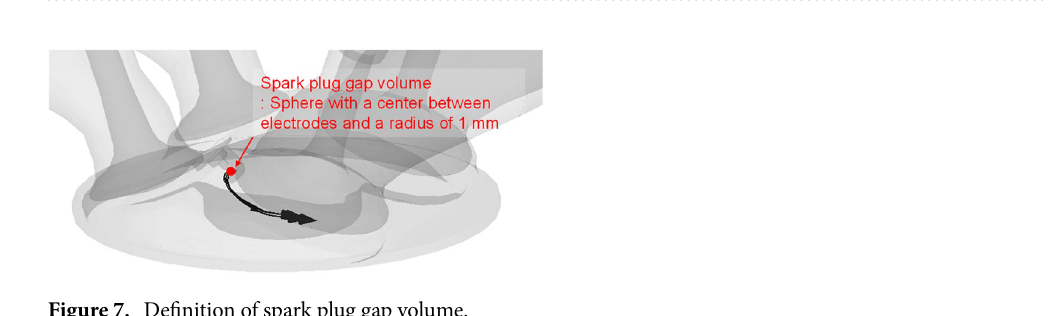
Figure 7. Definition of spark plug gap